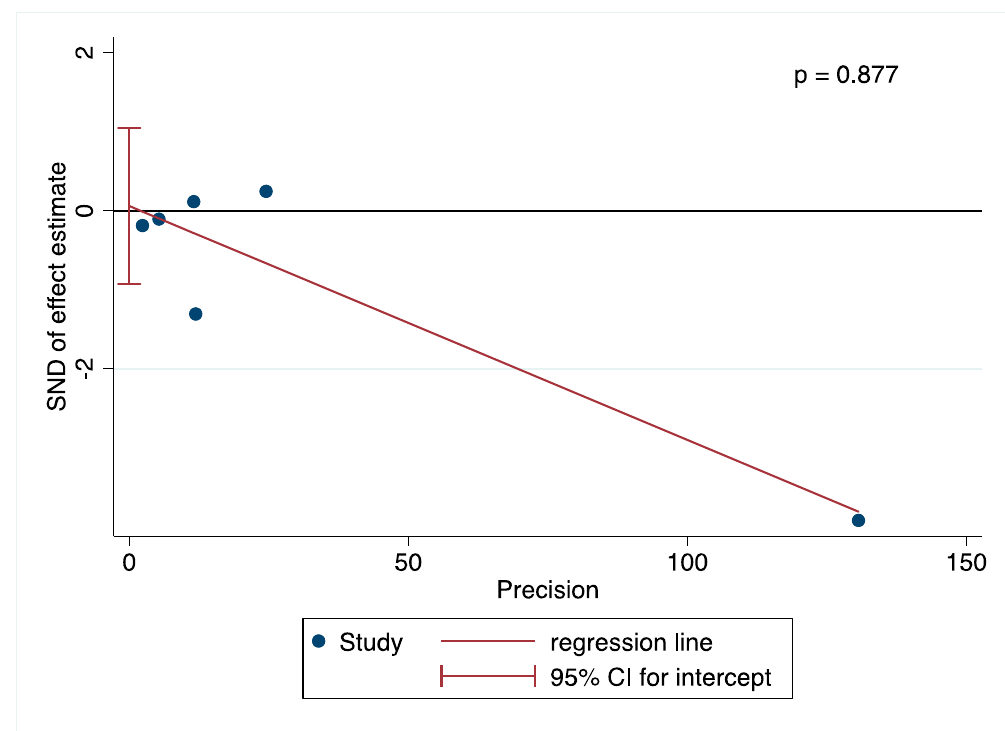
Figure 3. Assessment of potential publication bias by Harbord test.